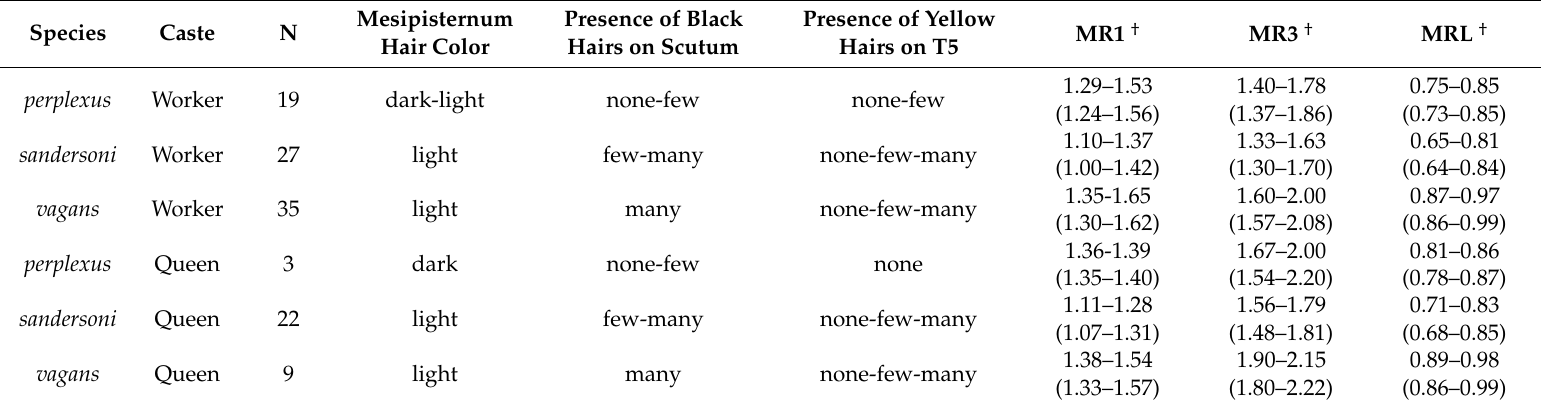
Table 3. Characteristics, observed, and predicted measurement ranges † for the three Bombus species in this